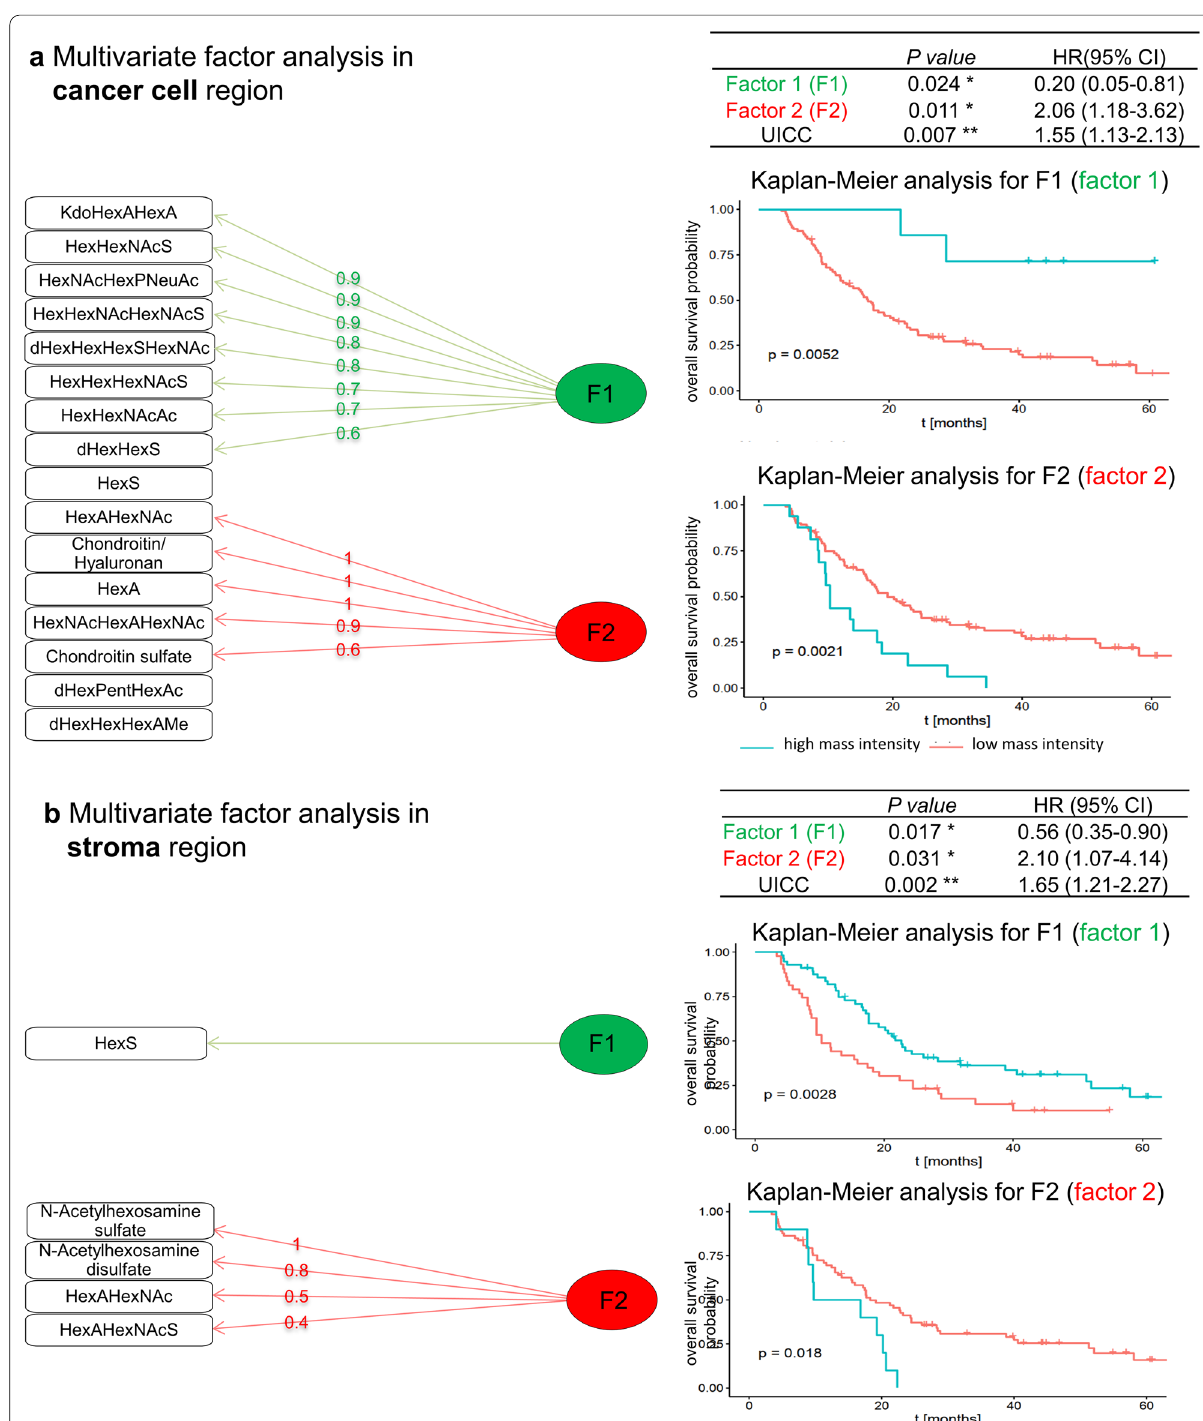
Fig. 3 a Multivariate factor analysis of significant glycan fragments identifies prognostic glycan factors in cancer cell region. b Multivariate factor analysis of significant glycan fragments identifies prognostic glycan factors in stromal region. The numbers on the arrows pointing from the factors to the individual glycan fragments represent the factor loading of each individual glycan fragment on that factor, which quantifies the extent to which the glycan fragment is related to a given factor. Values close to 1 or 1 represent strong relation, while values close to 0 indicate weak − relation. Blue line indicates high score of the factor. Red line indicates low score of the